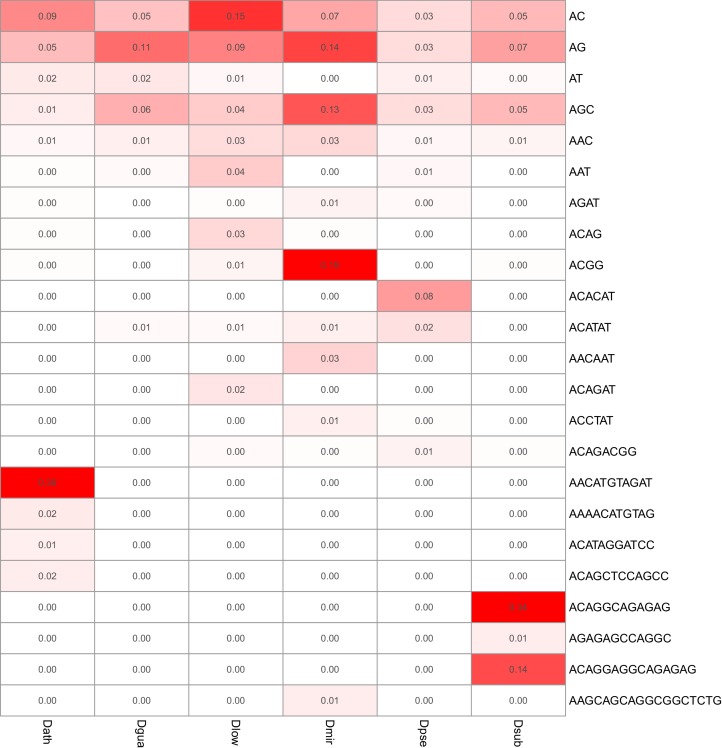
Short satellite DNAs in obscura group flies.Shown is a heatmap of the results from k-Sseek analyses used to identify enriched satellite sequences. Only kmers >1 bp that constitute >10% of the total short satellite sequence in any one species are shown. White = not present, red = highly enriched.